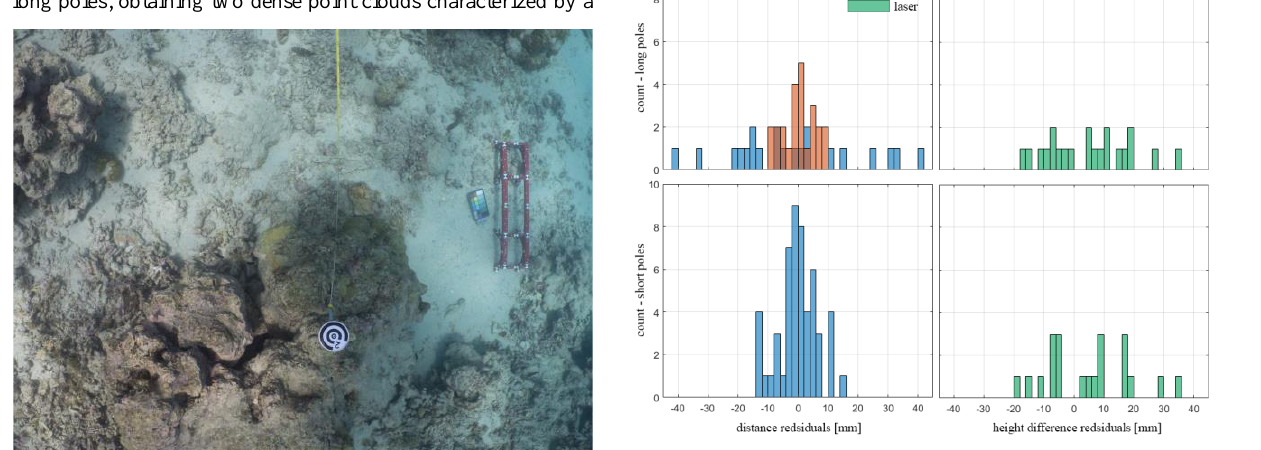
Fig.5: Distributions of distance and height difference residuals of the geodetic network adjustment for long (top row) and short (bottom row) pole lengths.